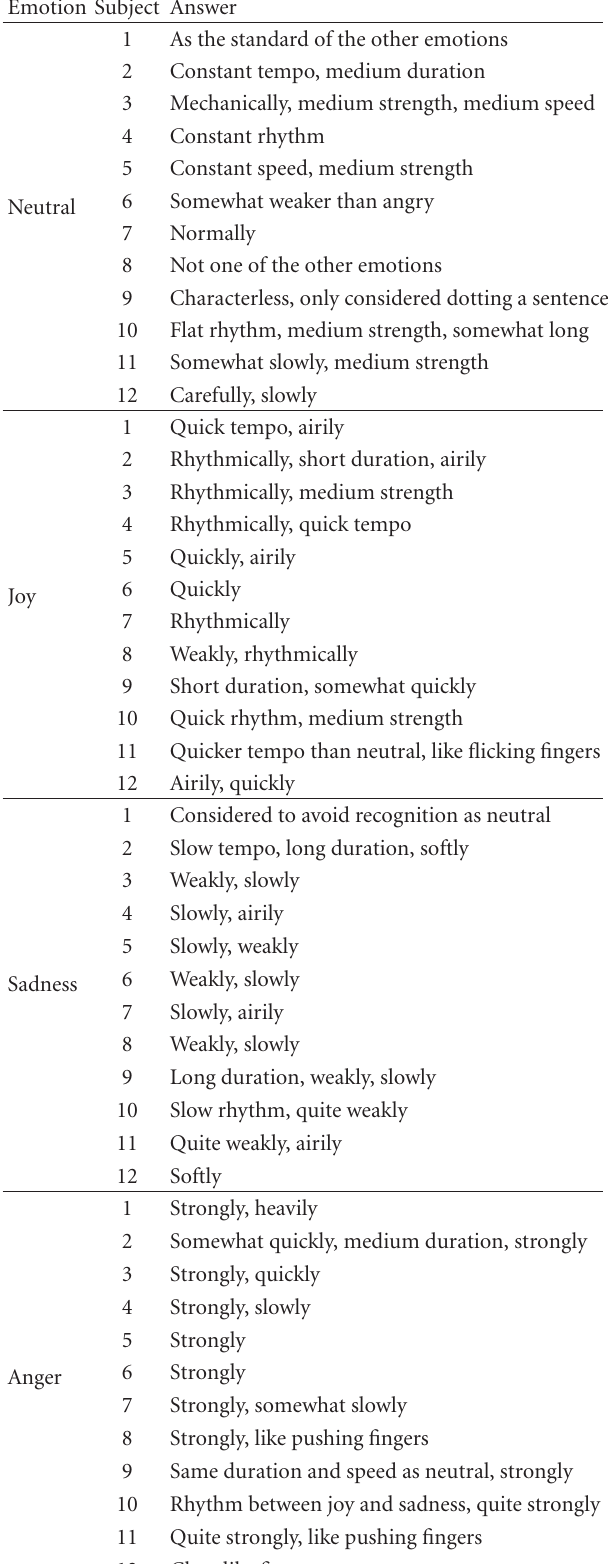
Table 7: Responses of unskilled senders to questionnaire on exp- ressing